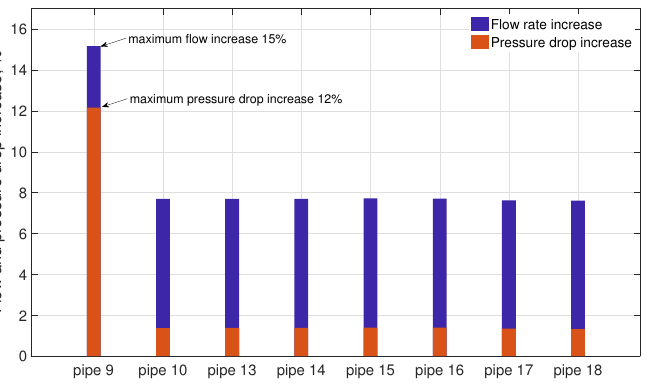
Figure 10. Pressure drop and flow rate increase after H 2 injection in pipes that have hydrogen mixture.